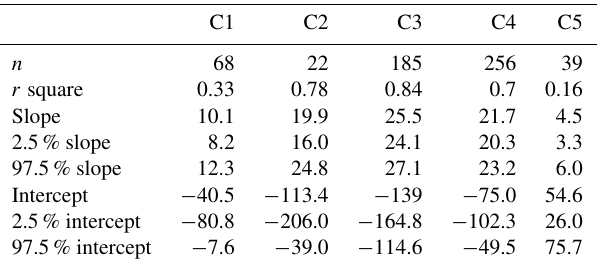
Table A1. Parameters for reduced major axis (RMA) regression be- tween Na + and Ca 2 + for the five